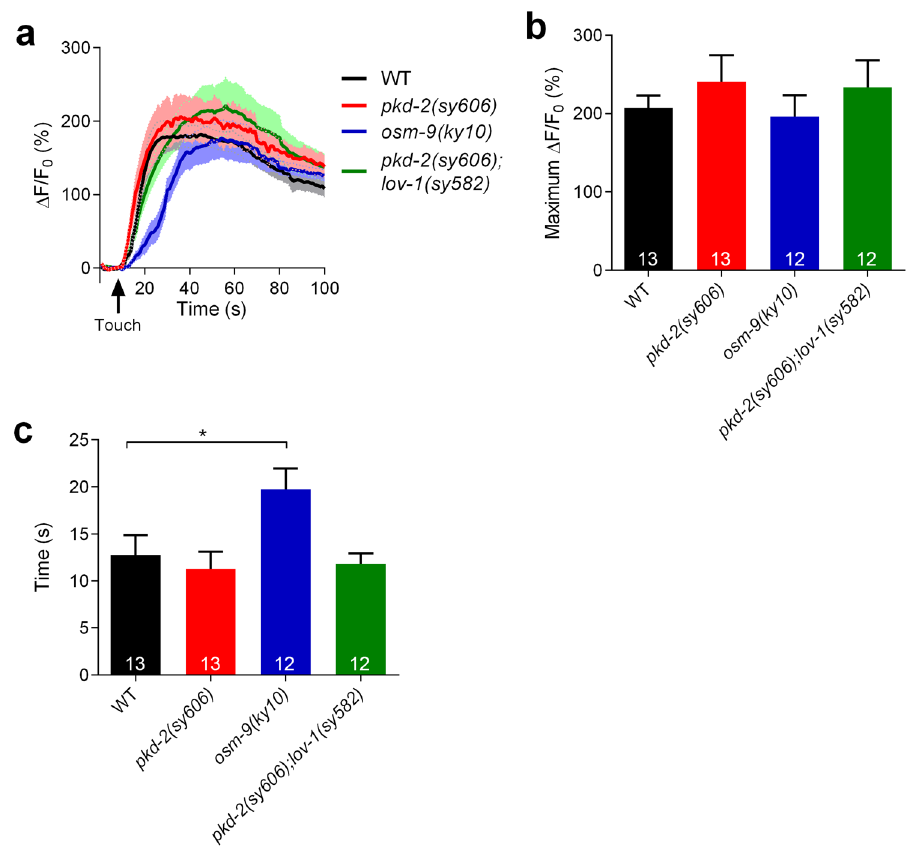
Figure 4. OSM-9, but not PKD-2, is involved in touch-induced calcium responses in RnB neurons. ( a , b ) Averaged calcium responses ( a ) and maximum Δ F/F0 changes ( b ) in R1B-R3B neurons induced by mechanical stimulation of 15 μ m displacement at the position of rays 1–3 in wild type, pkd-2(sy606) mutants, osm-9(ky10) mutants, and pkd-2(sy606);lov-1(sy582) double mutants. Solid lines show the average fluorescence changes and the shading indicates SEM. ( c ) Half-maximum response times of touch induced-calcium responses in R1B-